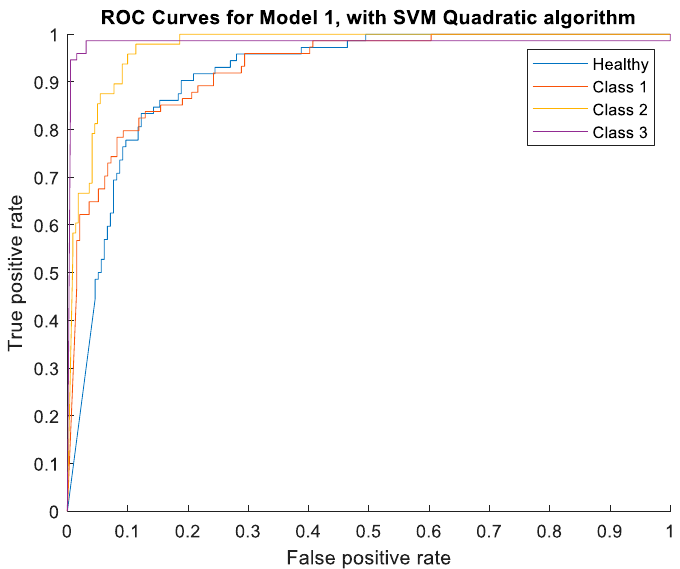
9 of 15 Table 3. Metrics scores for Model 1, with 4 classes. Algorithm